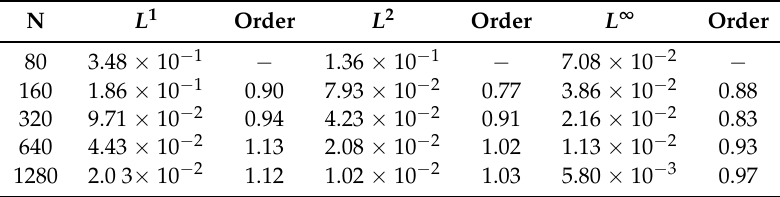
Figure 1. Results of numerical simulations. ( a , b ): the scheme (4)/(6)/(7); ( c , d ): the scheme (9)/(10)/(11). Table 2. Relative errors of the scheme